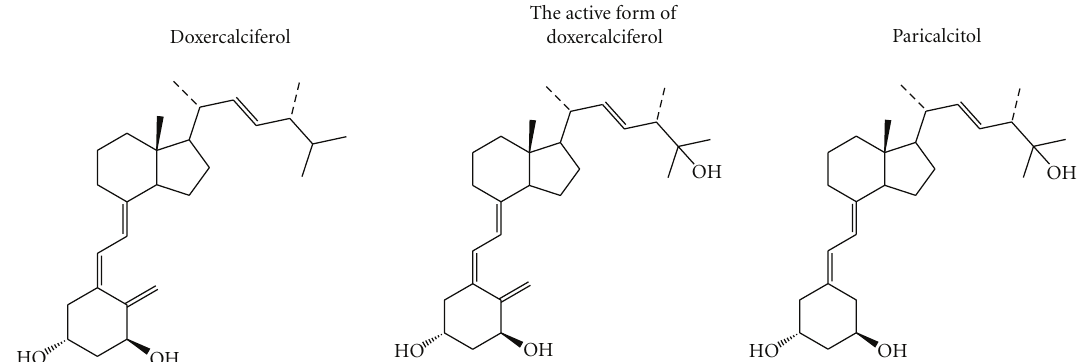
Figure 1: The structures of doxercalciferol, the active form of doxercalciferol and paricalcitol.